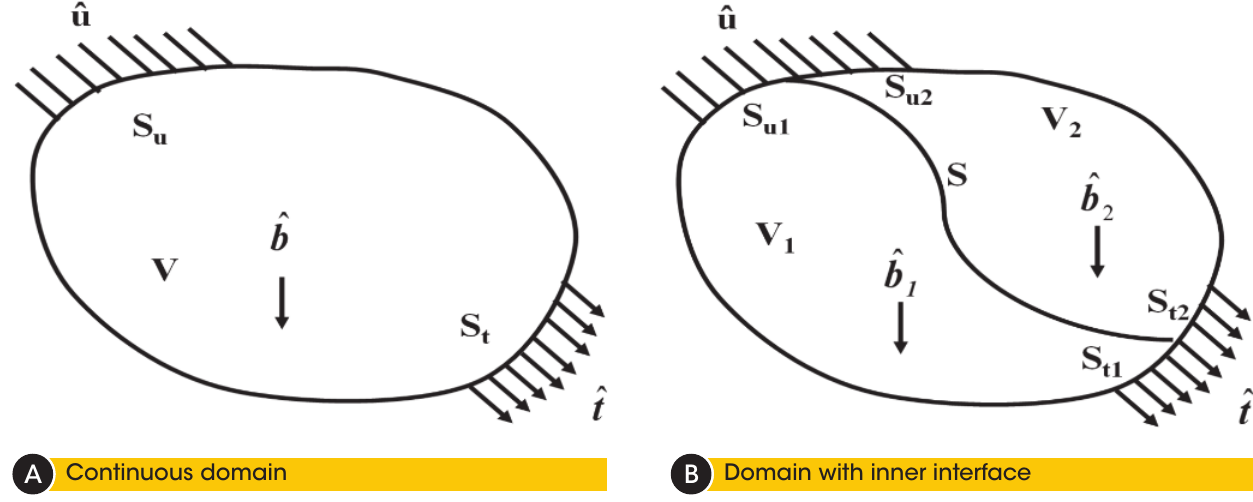
Continuous domain Domain with inner interface B B A Figure 1 Boundary condition in the domain. a) continuous, b) with inner interface